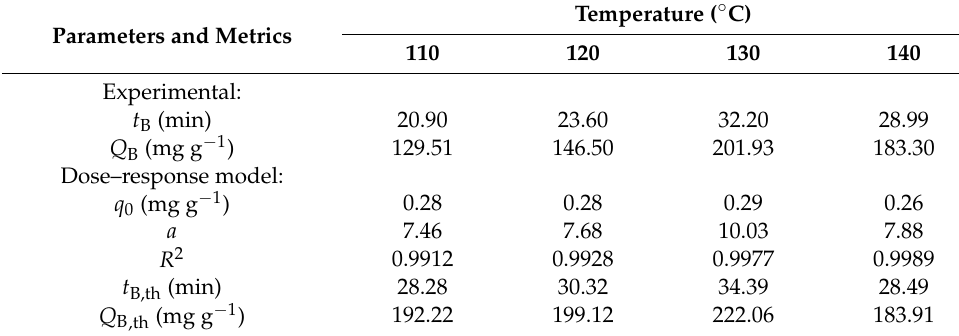
Figure 2. Experimental breakthrough dot plots and the dose–response model fitting curves at different temperatures. Table 1. Adsorption metrics and model parameters of anisole at different temperatures.